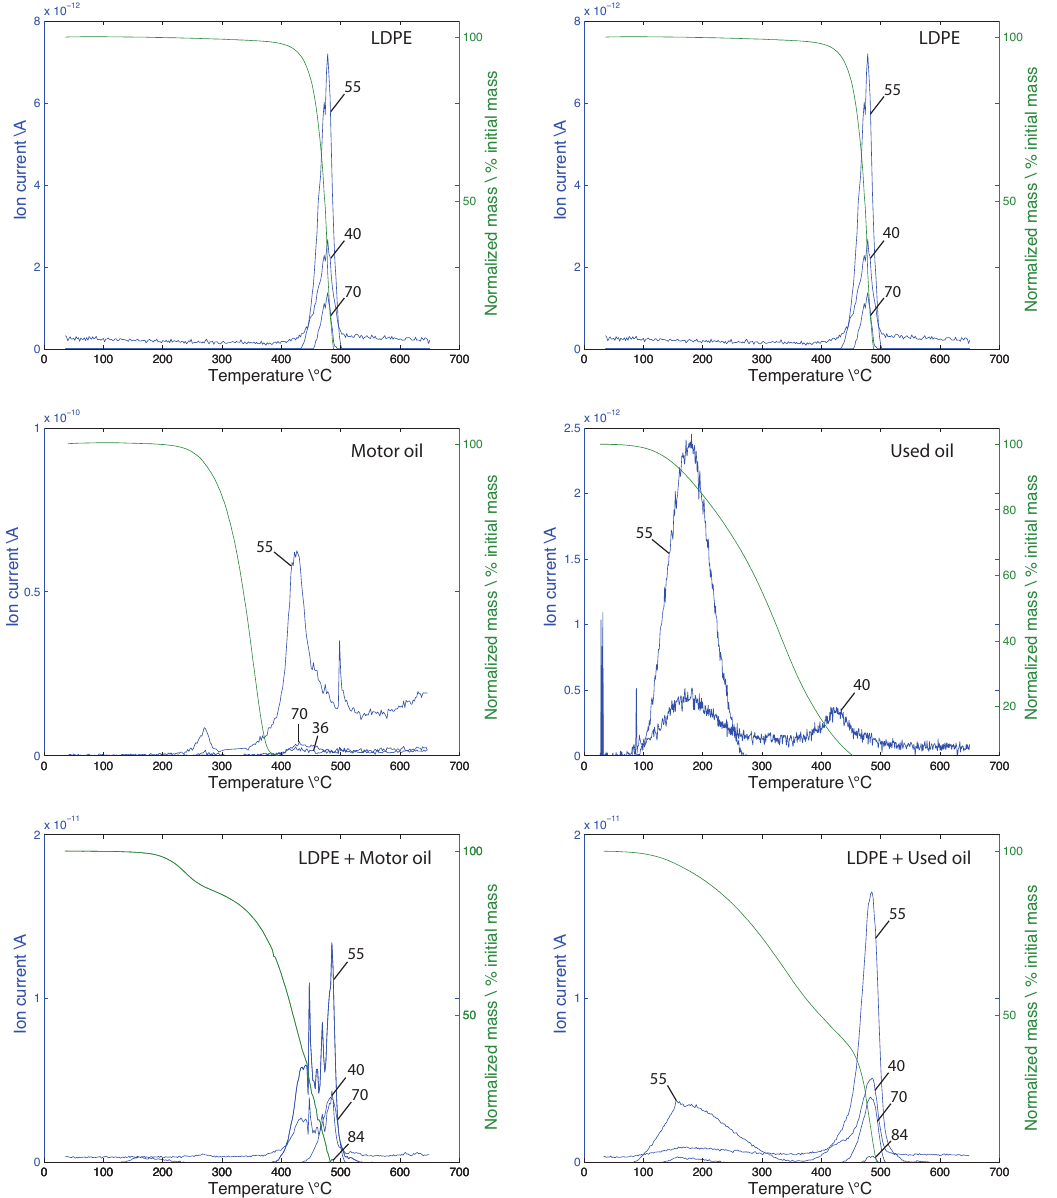
Figure 3. TGA-MS experiments performed on LDPE, motor oil, used oil and mixtures of plastic and oil. The m/z traces shown are 36, 40, 55, 70, and